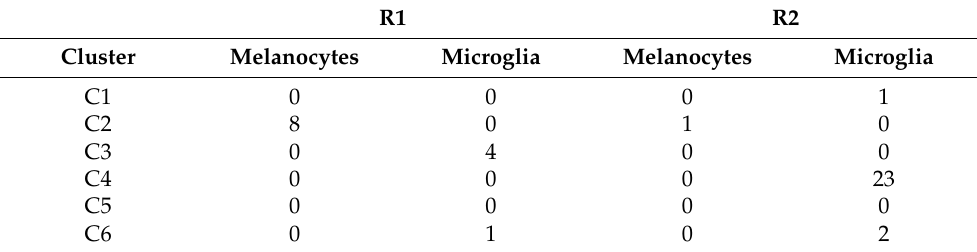
Table 2. Number of cells in each RPE cluster identified as melanocyte and microglial cell types using